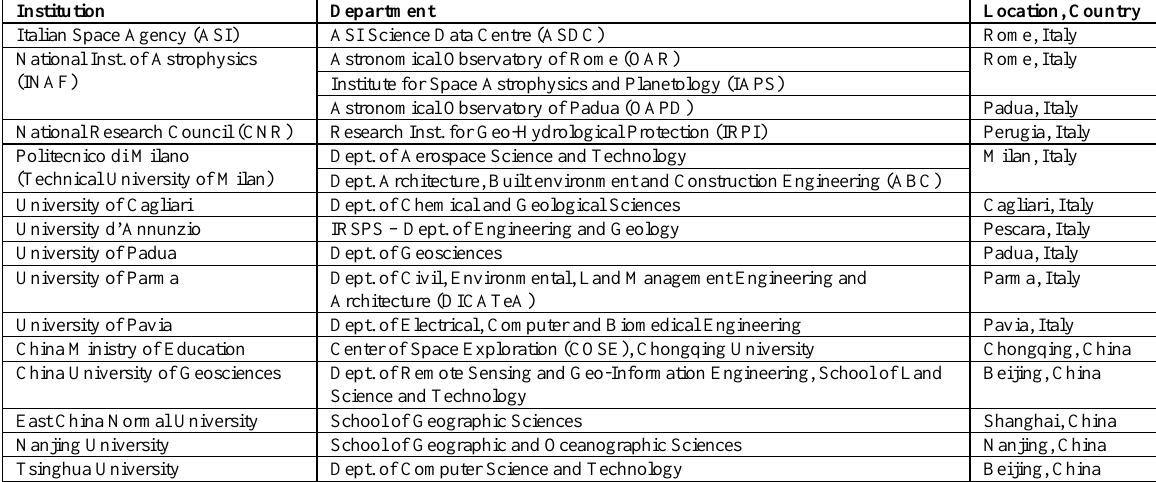
Table 1. - Members of ‘Moon Mapping Project’ between Italy and